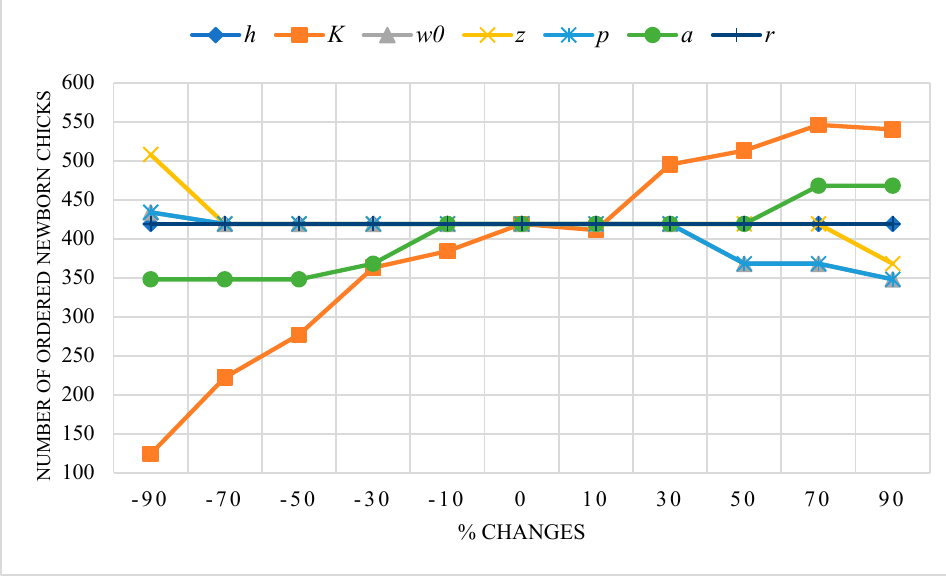
Figure 8. The effects of the parameter’s fluctuations on the optimal value of the order quantity.